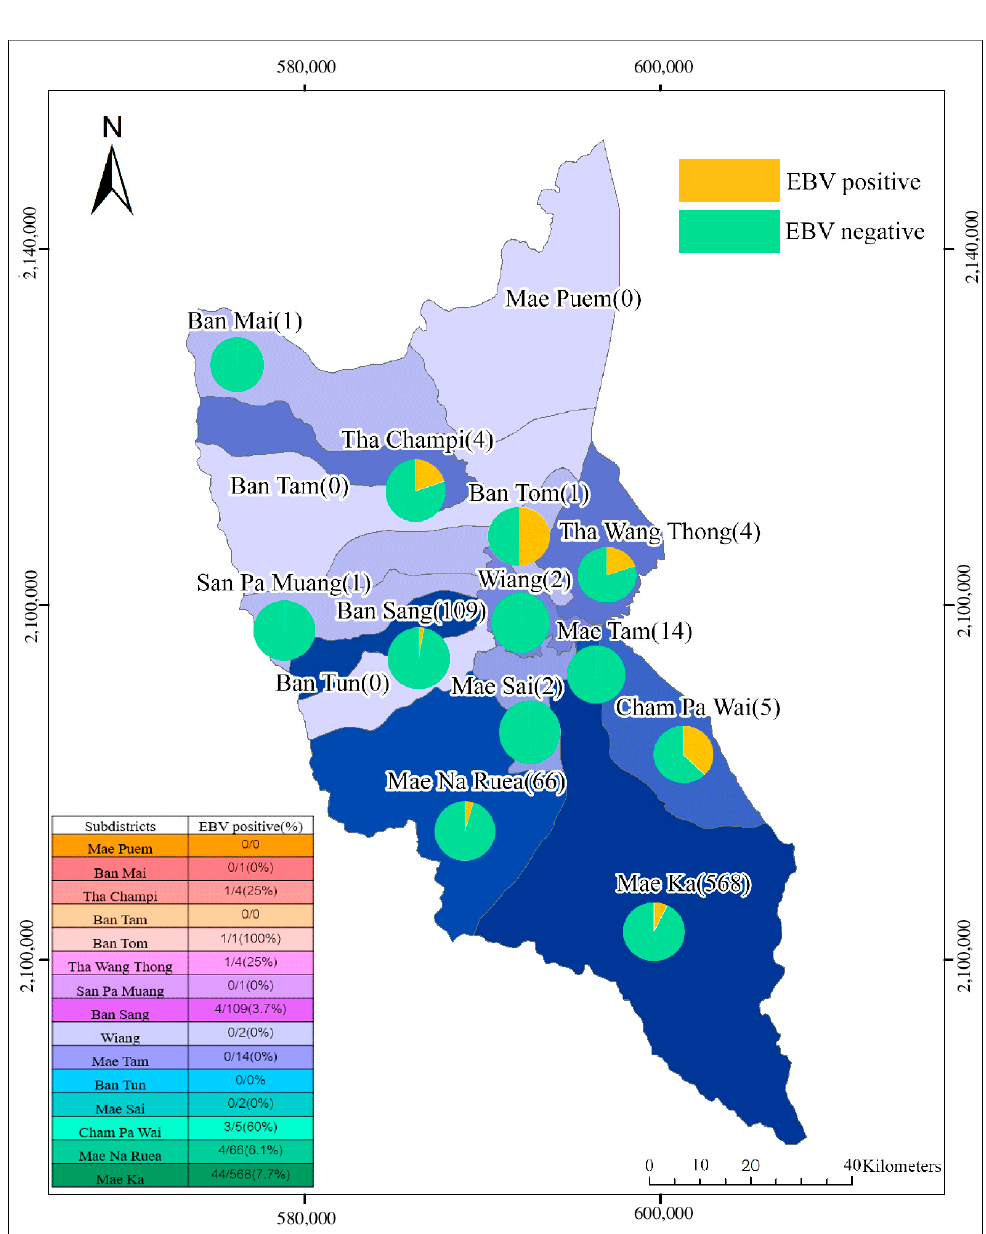
Figure 4. GIS-connected oncogenic EBV prevalence data from human blood samples in the 15 Mueang subdistricts highlights the EBV distribution. EBV-positive means EBV-positive in human